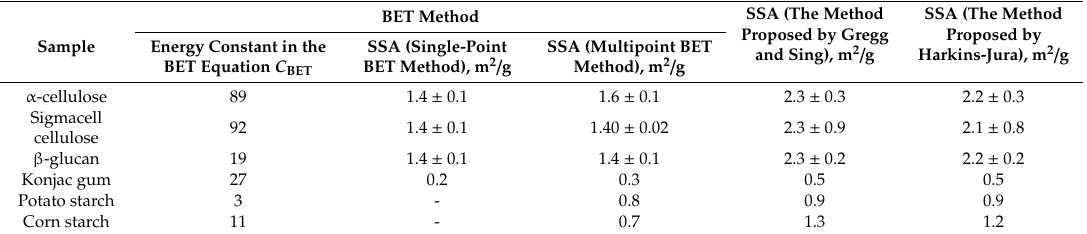
Table 1. Specific surface area (SSA) and surface characteristics of the isolated carbohydrates